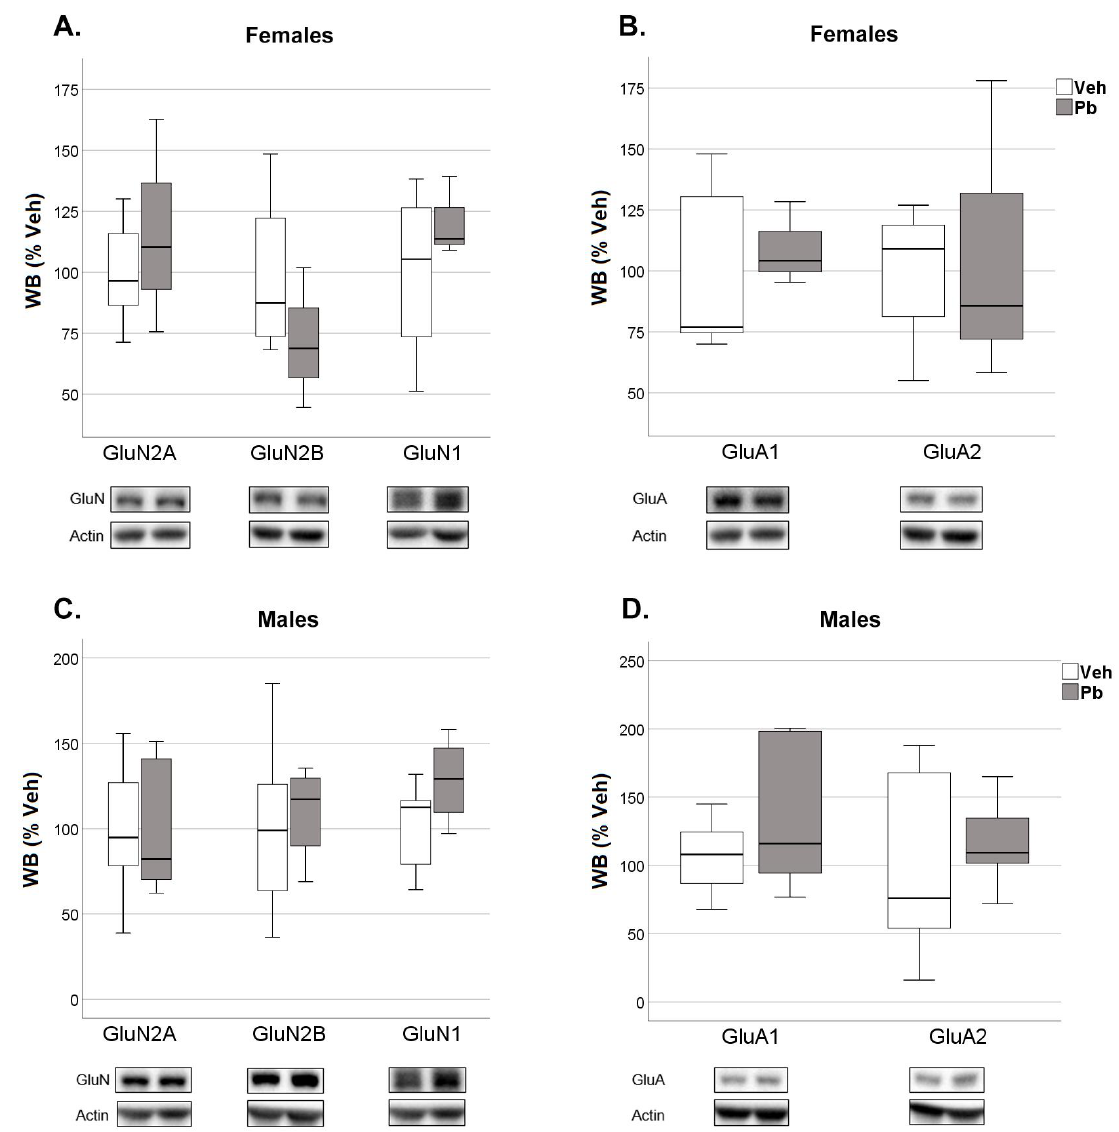
Figure 9. Effect of Developmental Pb Exposure on the Expression of NMDA and AMPA Receptor Subunits in the Triton-Insoluble Fraction (TIF) of 70 Post-Natal Day Female and Male Rat Hippocampi. Quantification and representative Western blots of glutamatergic receptor subunits in females ( A , B ) and males ( C , D ) in Veh and Pb rats. Data were normalized on actin levels and are represented as % of Veh ( n = 3–7).